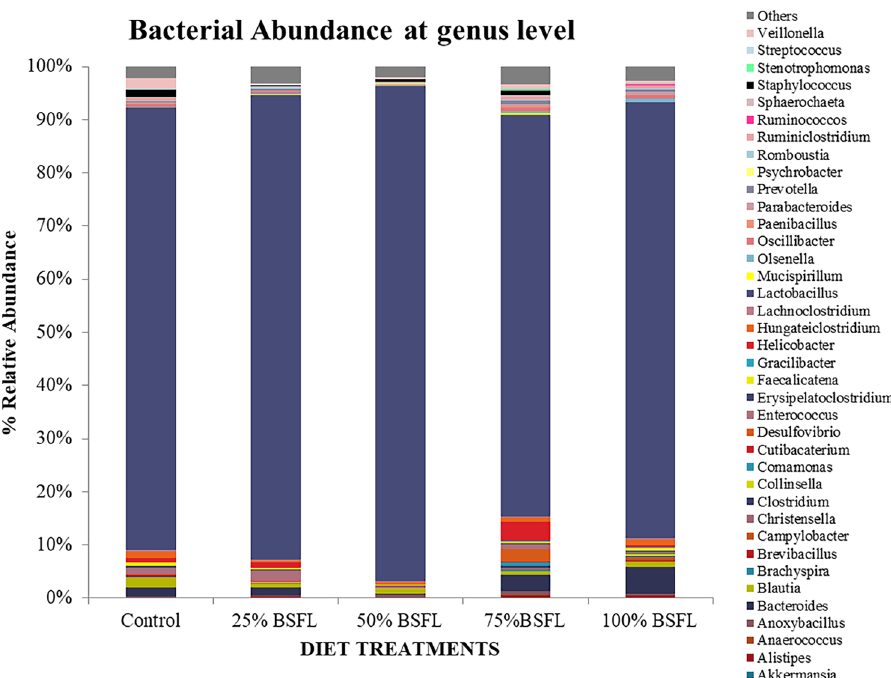
Figure 2. Cumulative abundance composition of bacteria Operational Taxonomic Units identified at the genus level across the different dietary treatments formulated from black soldier fly larvae–based